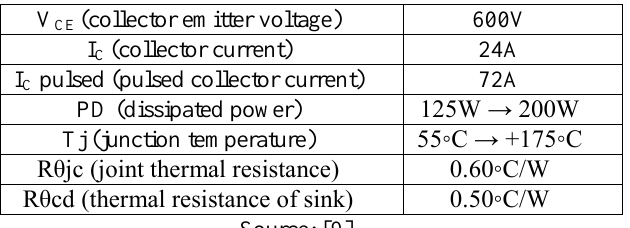
Table 3: Characteristics IRGB4062D.